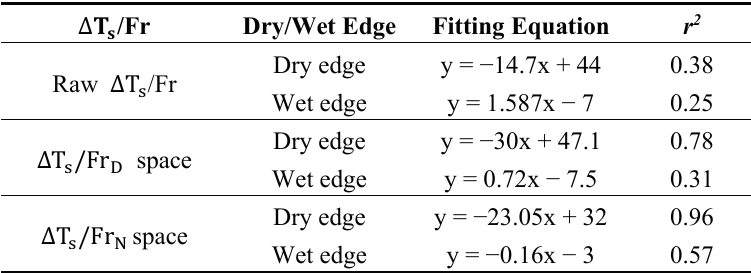
Table 3. The statistics of the dry and wet